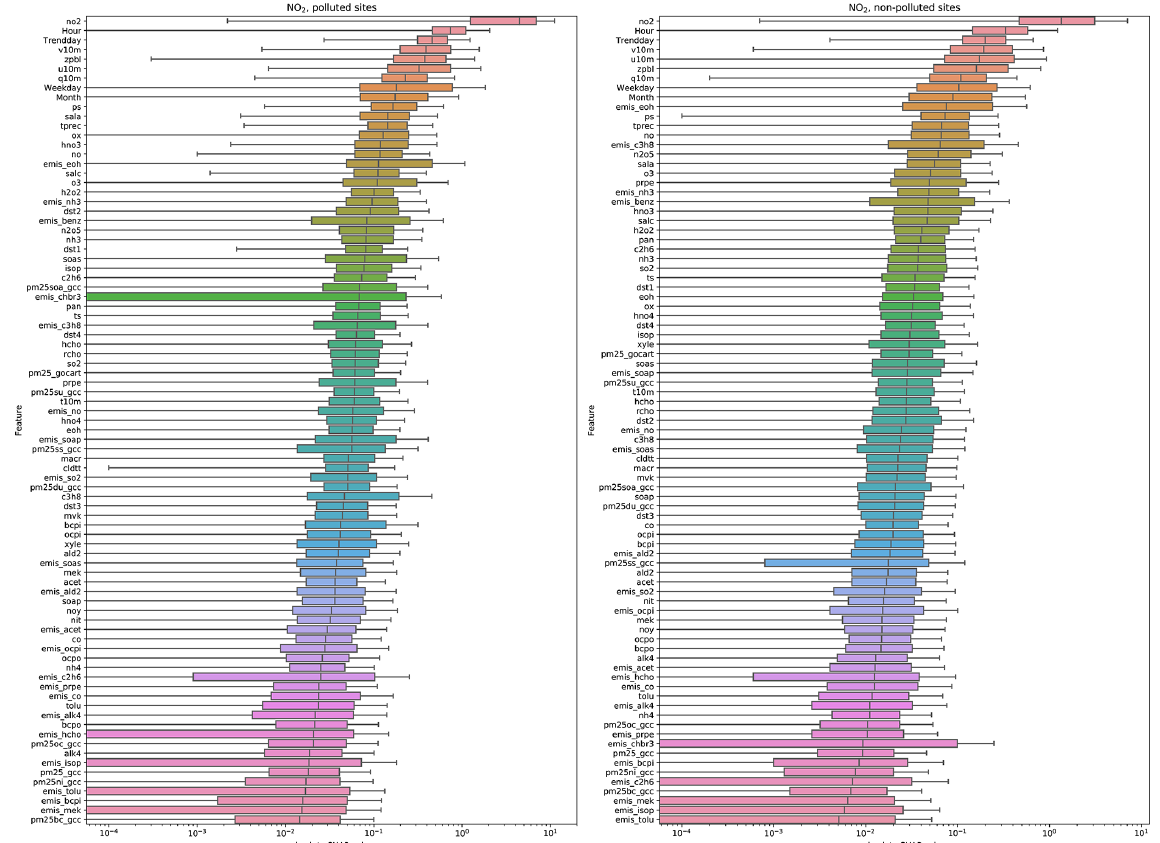
Figure A4. Importance of input variables (features) for the XGBoost models trained to predict NO 2 model bias. Shown are the distribution of the absolute SHAP values for each feature, ranked by the average importance of each feature. Higher SHAP value indicates higher feature importance. The left panel shows results for polluted sites (average annual NO 2 concentration > 15ppbv) and the right panel shows results for all other